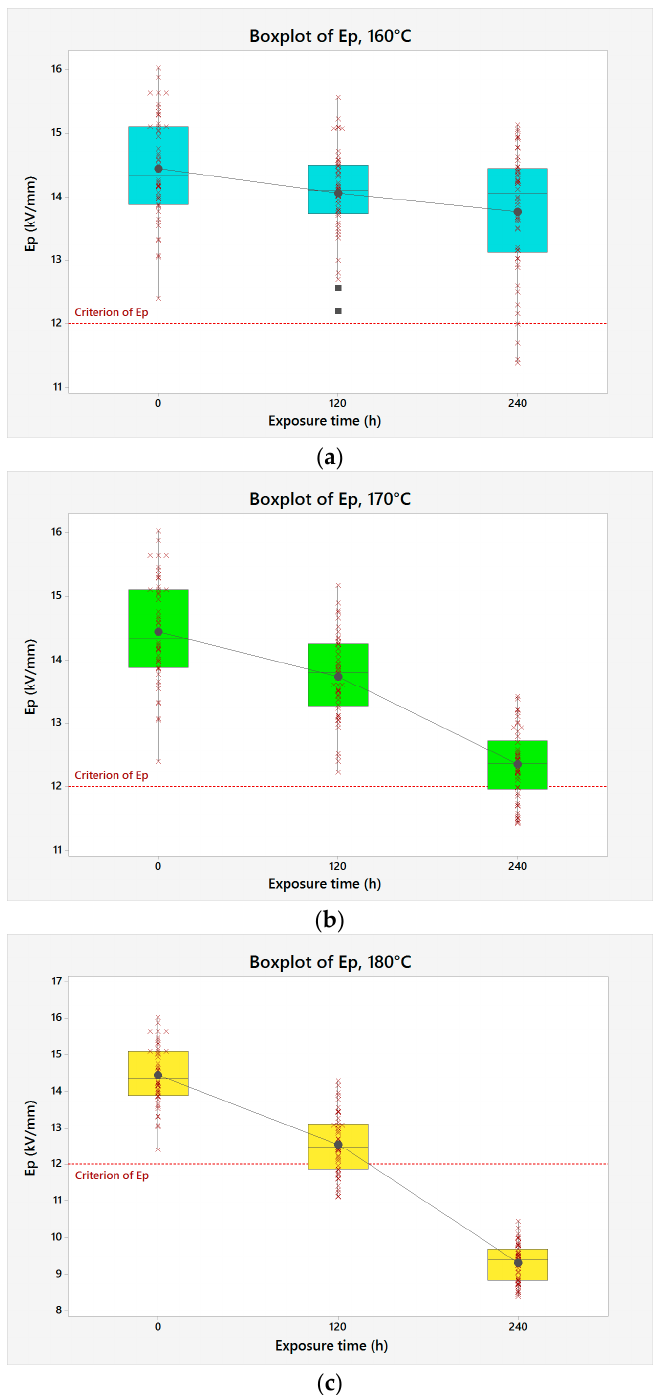
Figure 7. Dependence of dielectric strength (Ep) on degradation temperature: ( a ) 160 °C; ( b ) 170 °C; and ( c ) 180 °C.